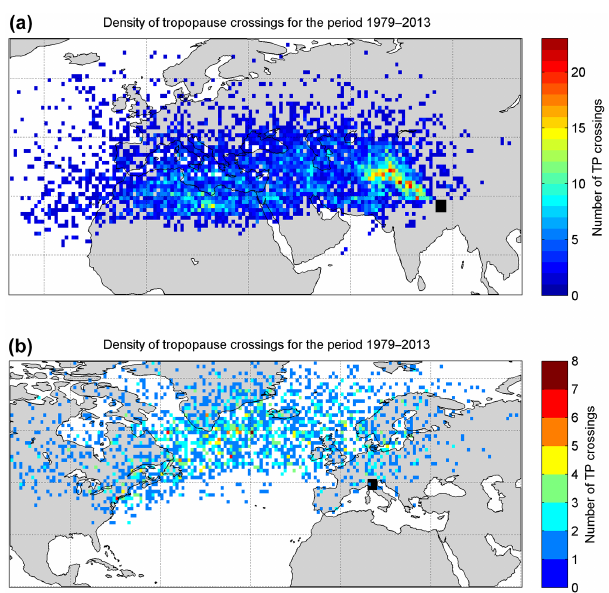
Figure 4. Density of tropopause (TP) crossings for the period 1979– 2013, for NCO-P (a) and Mt. Cimone (b) . Values for both figures were aggregated on a 1 ◦ × 1 ◦ horizontal grid. In both panels, the black square indicates the horizontal extension of the STEFLUX